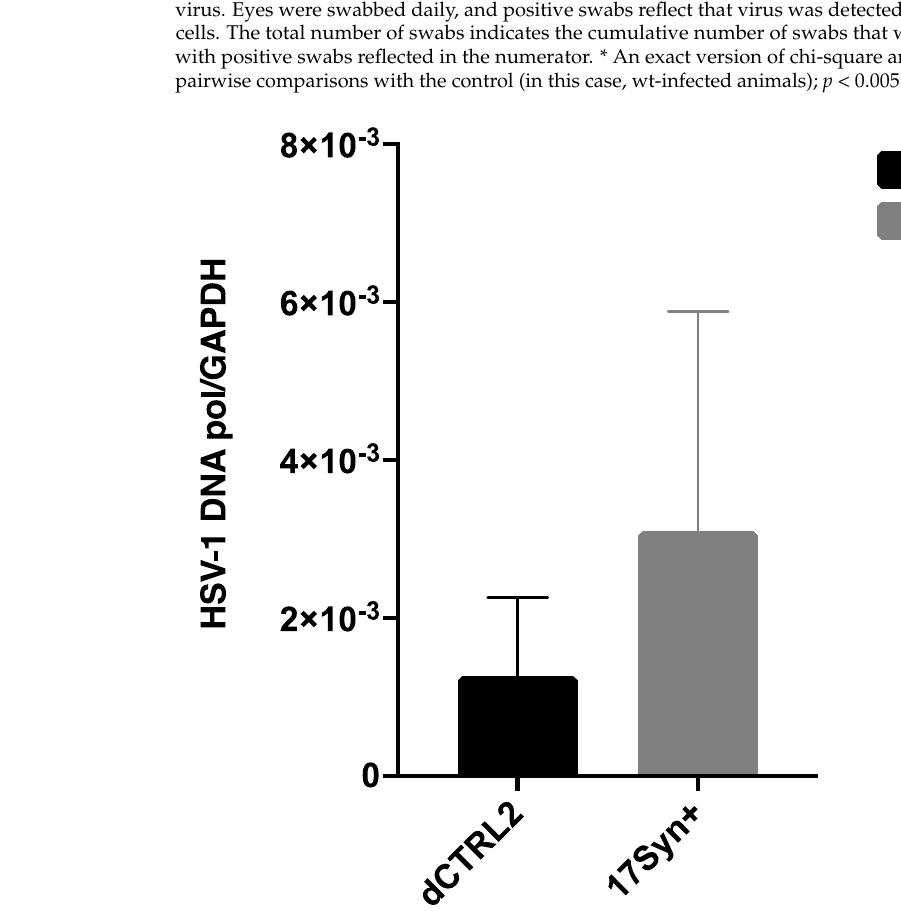
Figure 2. HSV-1 genome copies in rabbit ganglia in wt 17Syn+ and the Δ CTRL2 recombinant following infection. The number of HSV-1 genomes per ganglia was determined between wt 17Syn+ and Δ CTRL2 viral infections in rabbits. Relative copies of HSV-1 DNA polymerase were determined by PCR at 28 dpi. qPCR data is presented as a ratio of HSV-1 DNA pol/rabbit GAPDH. One-way ANOVA of independent samples was used to determine the statistical significance between the mutant and wt ( n = 6).